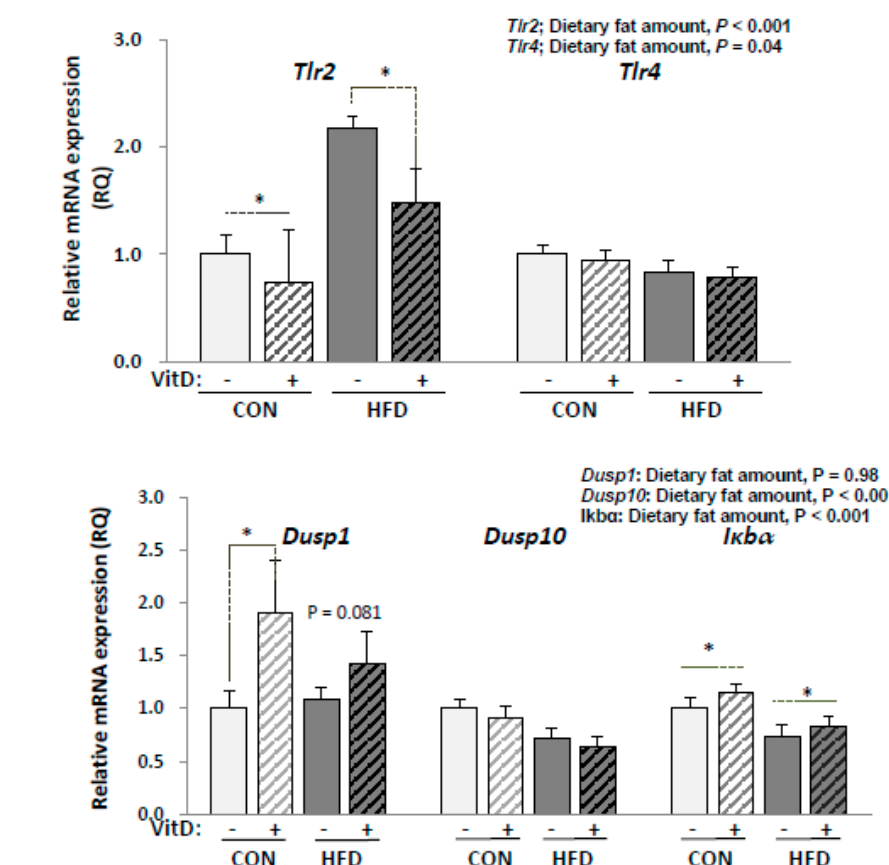
Figure 5. The mRNA levels of ( A ) Tlr and ( B ) Dusp and I κ b α in SVCs. Data are presented as mean ± SEM, n = 9~10 for each group. A paired t -test was used to determine the significant effects of in vitro 1,25(OH) 2 D 3 treatment and * indicates a significant difference ( p < 0.05). A student’s t test was used to determine the significant effects of the amount dietary fat. CON: 10% kcal fat diet; HFD: 60% kcal fat diet. Tlr2 , toll like receptor 2; Tlr4 , toll like receptor 4; Dusp1 , dual specificity protein phosphatase 1; Dusp10 , Dual specificity protein phosphatase 10; I κ b α , nuclear factor of kappa light polypeptide gene enhanced in B-cells inhibitor alpha.